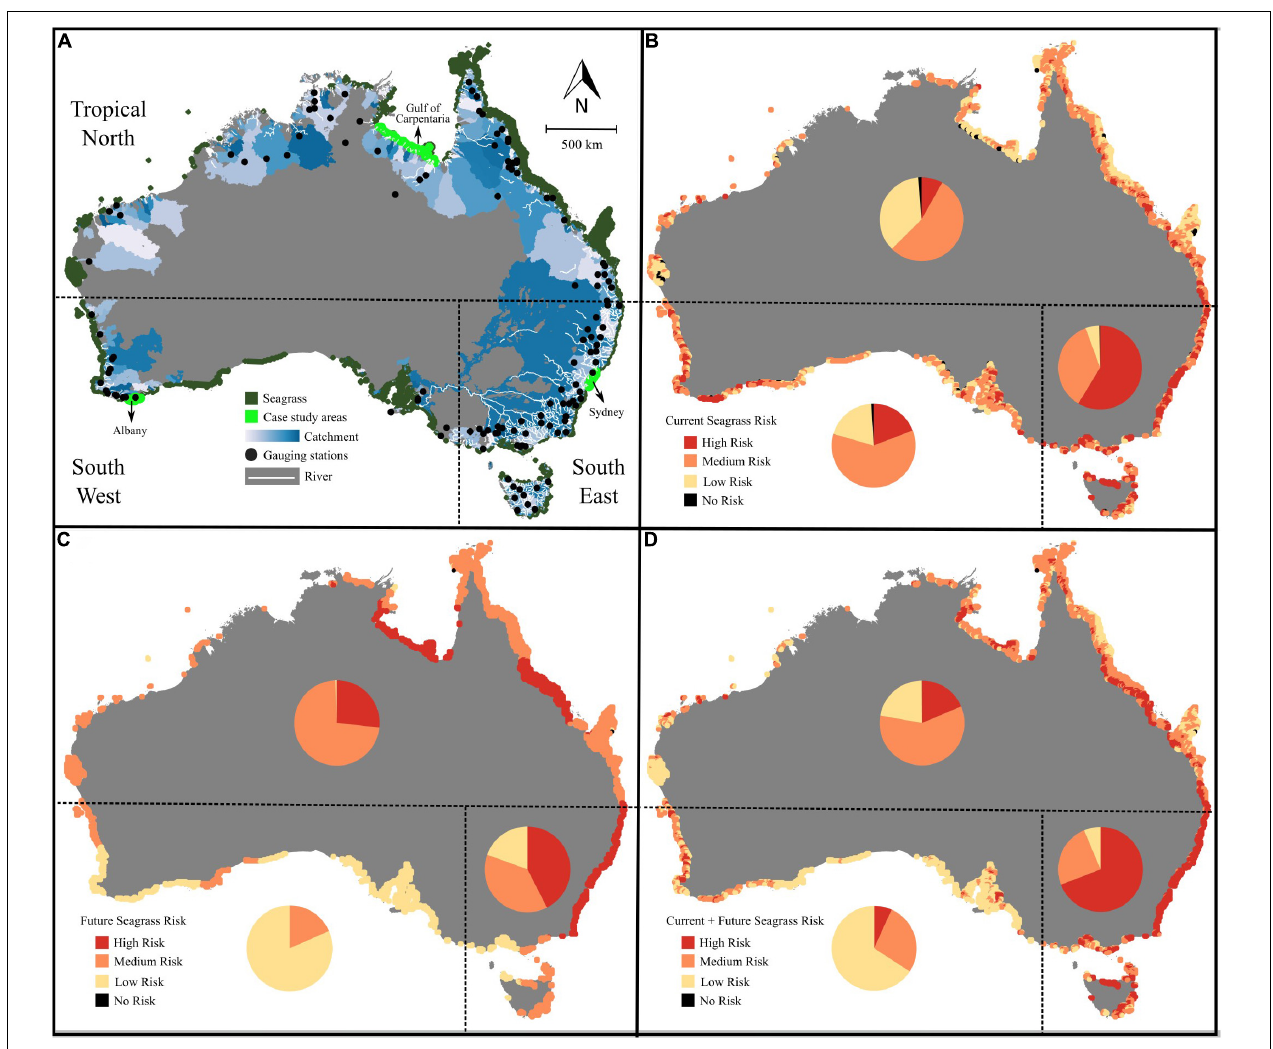
FIGURE 2 | Australia-wide map showing three seagrass bioregions with (A) seagrass habitat, major rivers, size of catchments and case study areas of 30 pixels (as seagrass habitat generally forms a narrow band along the coast it has been expanded to make it visible at this scale), (B) cumulative current risk, (C) cumulative future risk, and (D) current and future risk combined. Pie charts in each bioregion show the proportion of cells with high, moderate or low cumulative risk. Seagrass in the south-east bioregion has higher proportion of high-risk in all